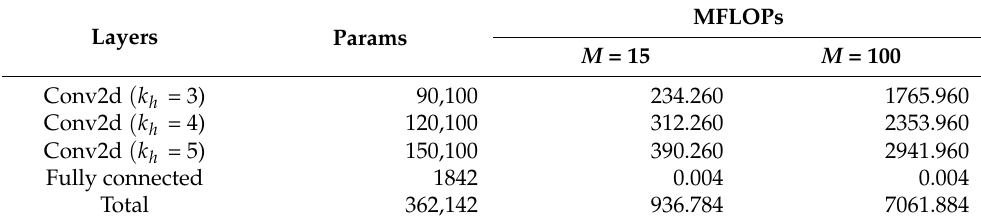
Table 3. The computational complexity of the LMT-CNN model.